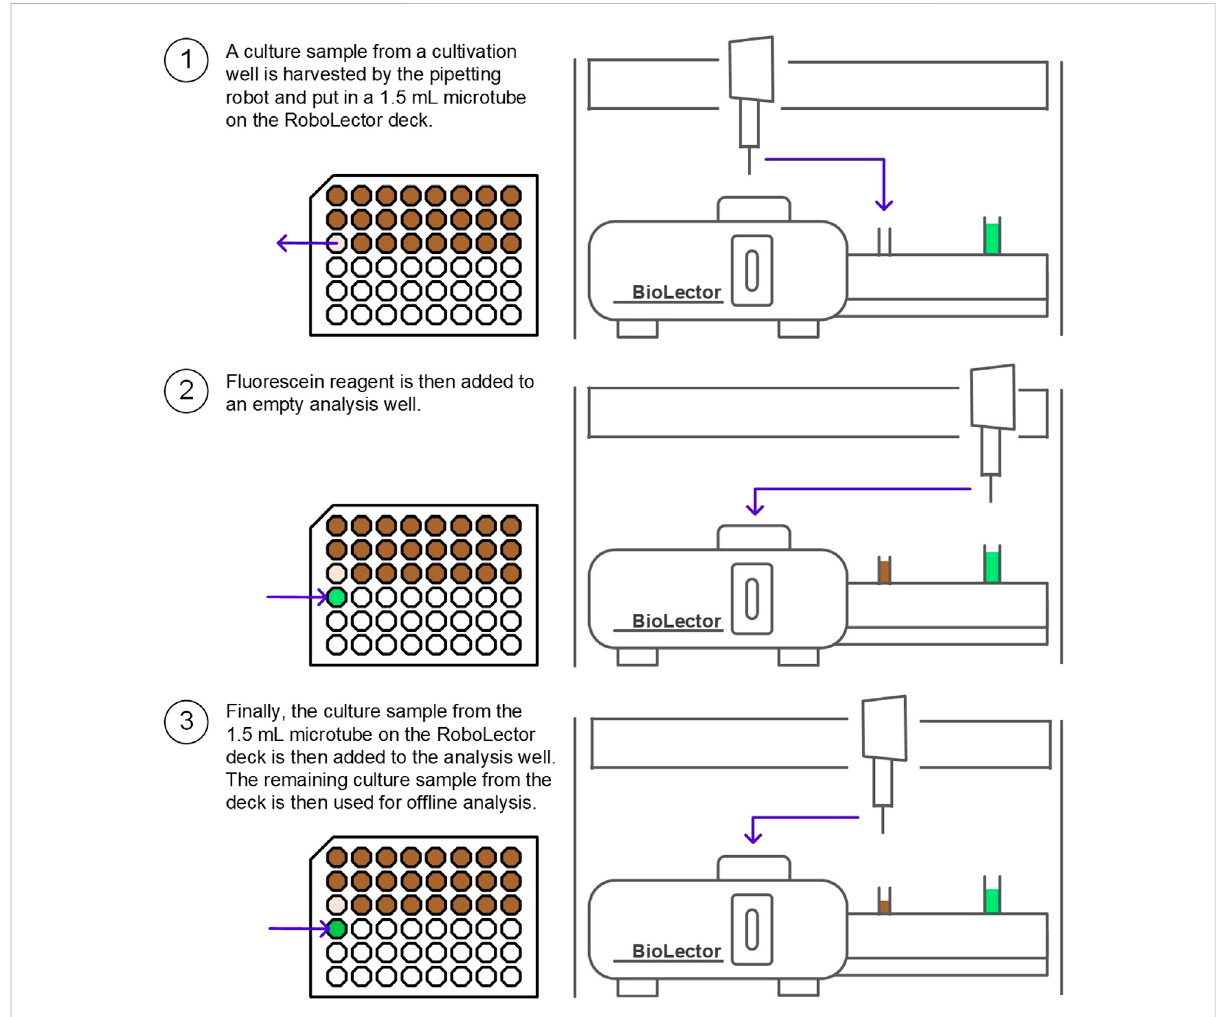
Overview of urease activity assay for automated microbioreactor experiments. A culture sample is illustrated in brown and the fl uorescein reagent is illustrated in green. On the left, a top view of the microplate is shown. On the right, a frontal view of the RoboLector system is illustrated. When no of fl ine analysis is necessary, 70 μ L of culture are enough for sample